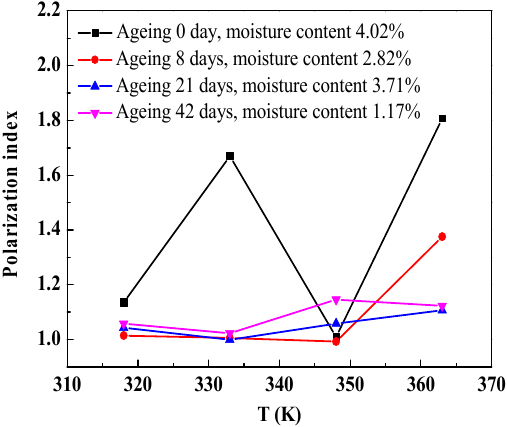
Figure 14. Relations between polarization index and absolute temperature T .